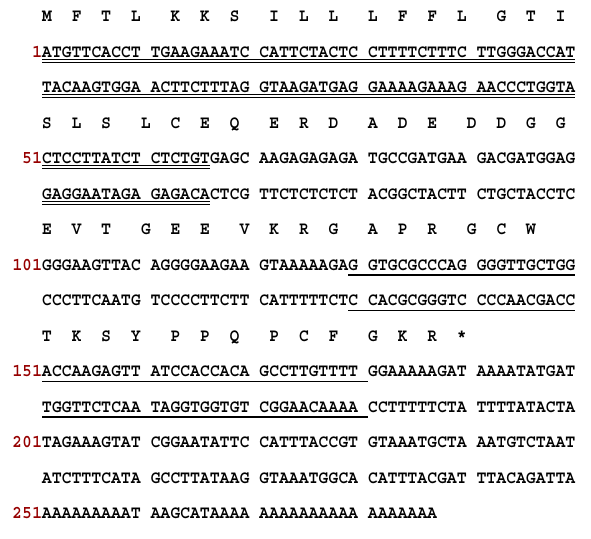
Figure 1. Nucleotide and deduced amino acid sequences of cDNA encoding RNF from Pelophylax nigromaculatus . There are 63 amino acid residues within the open-reading frame. The putative signal peptide sequence is double-underlined. The following acidic spacer peptide ends with a typical -K-R- cleavage site. The deduced mature peptide is shown with a single underline and the stop codon is marked with an asterisk.